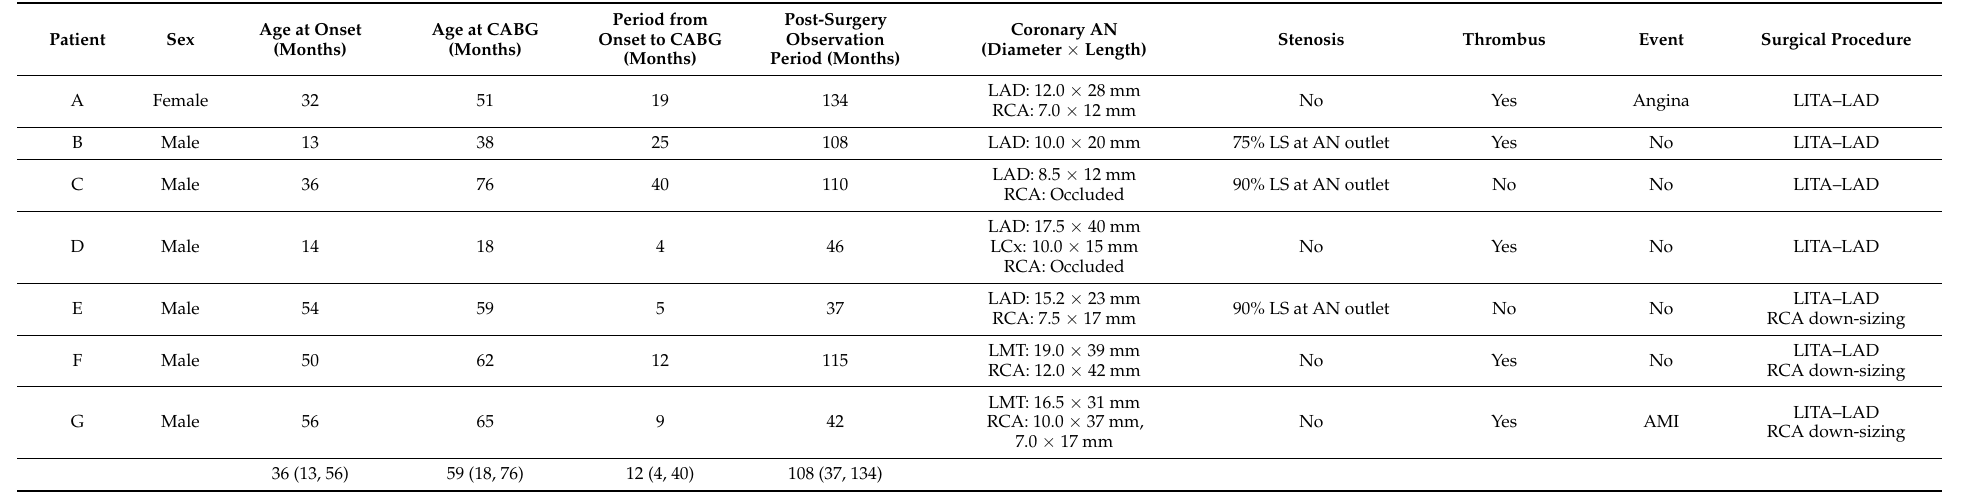
Table 1. Patient background and surgical